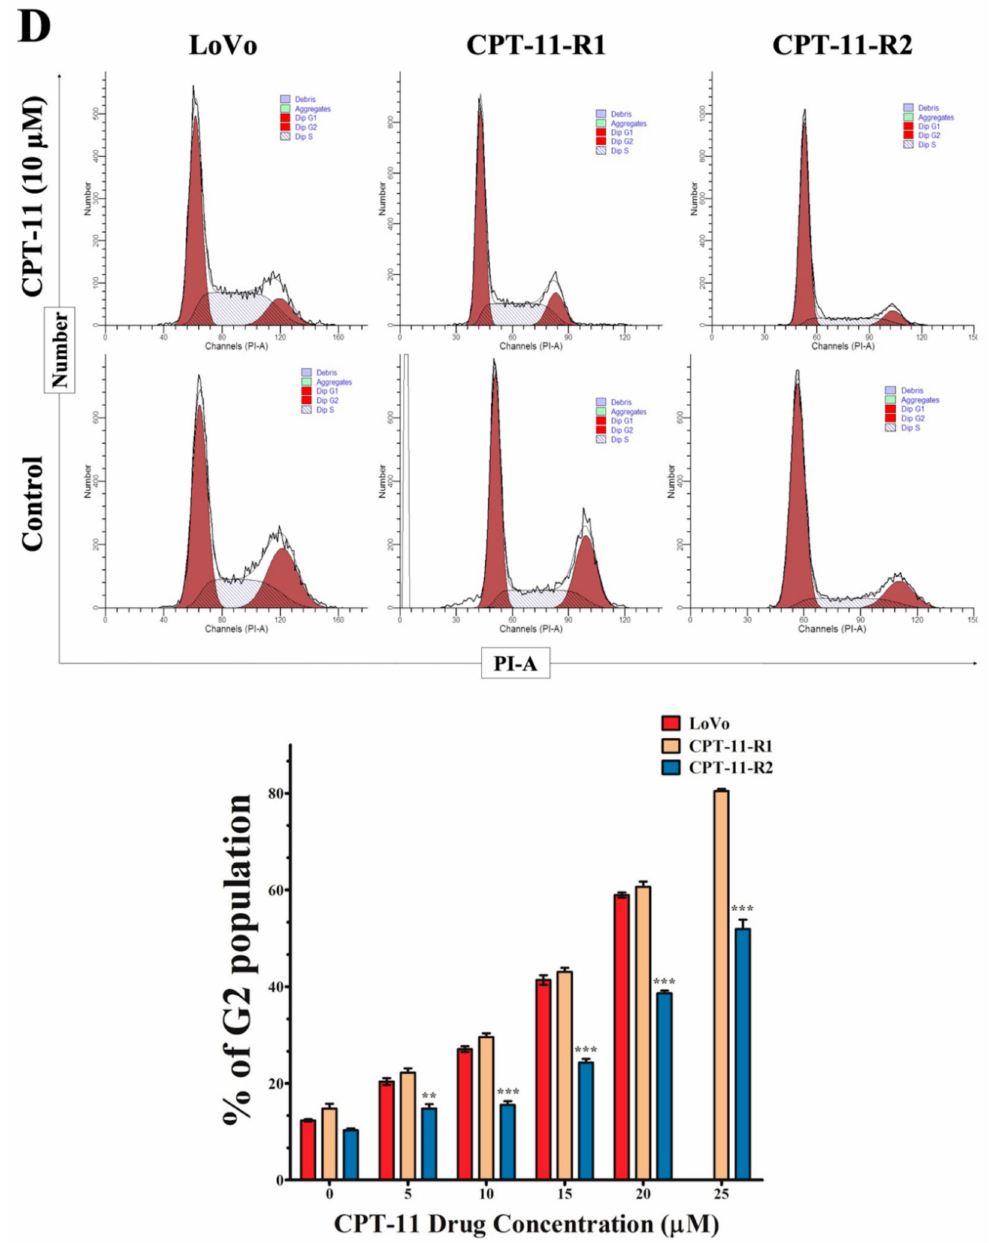
Figure 2. Reduced apoptosis and cell cycle alterations in chemoresistant CPT-11-R cell clones. ( A ) Apoptosis for LoVo (Table shows cell death rate in %), ( B ) apoptosis for CPT-11-R1 (Table shows cell death rate in %), ( C ) apoptosis for CPT-11-R2 (Table shows cell death rate in %). ( D ) The cells were treated with di ff erent concentrations of CPT-11 drug (5, 10, 15, 20, 25 µ M) for 48 h (LoVo) and 72 h (resistant clones). Cell death rate and cell cycle determined using the FACS analysis. The results are presented as mean ± standard error of the mean ( n = 3). * p < 0.05, ** p < 0.01, *** p < 0.001 compared to